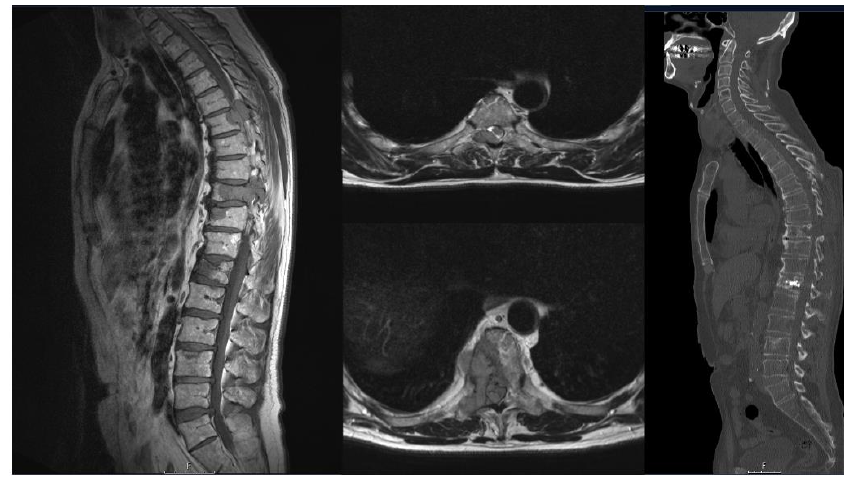
Figure 2. A 60-year-old patient presented with radical pain corresponding to dermatomes Th6 and Th9, which had been present for weeks.